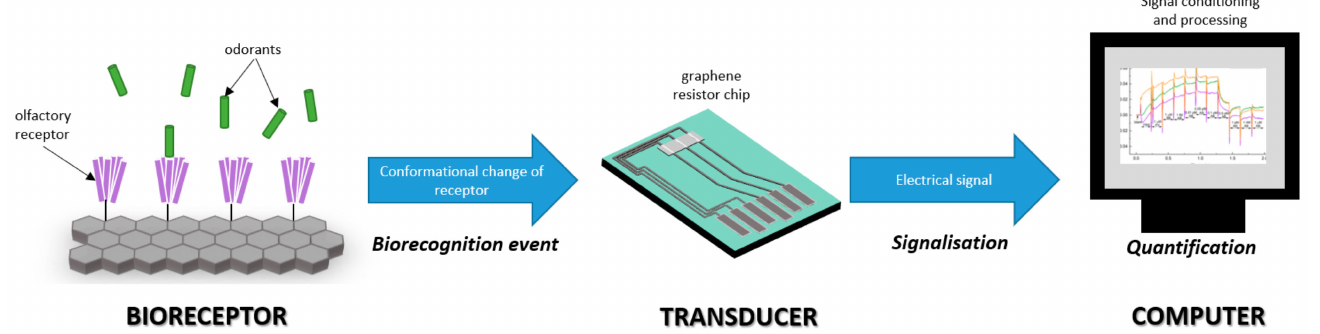
Figure 3. Schematic representation of signal transduction in the bioelectronic